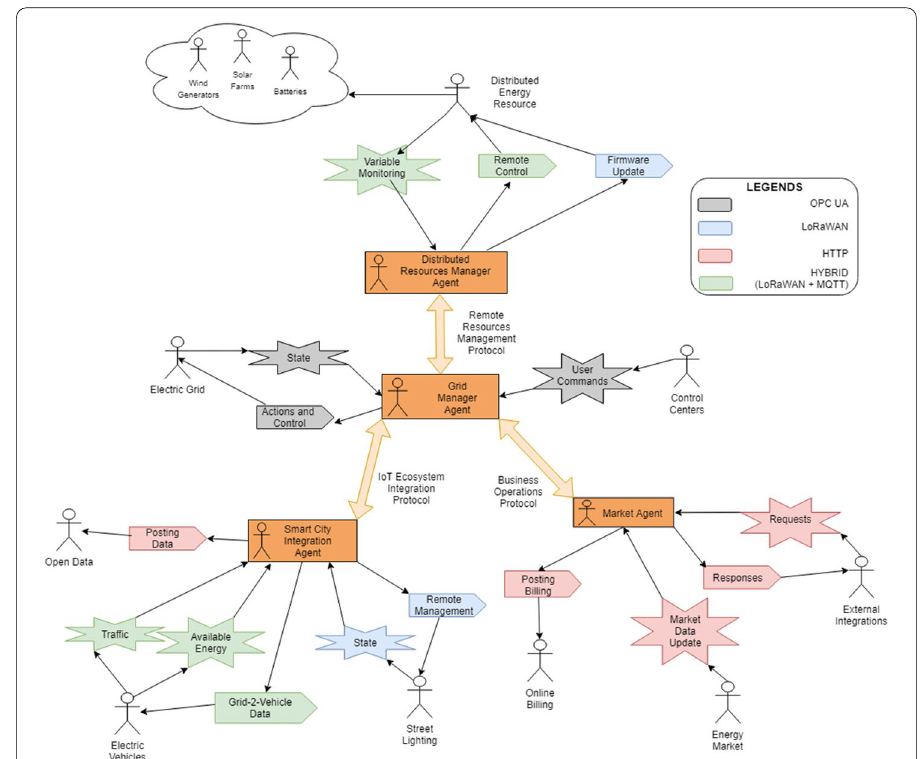
Fig. 5 Mapping between IoT protocols and a MAS to manage an electric